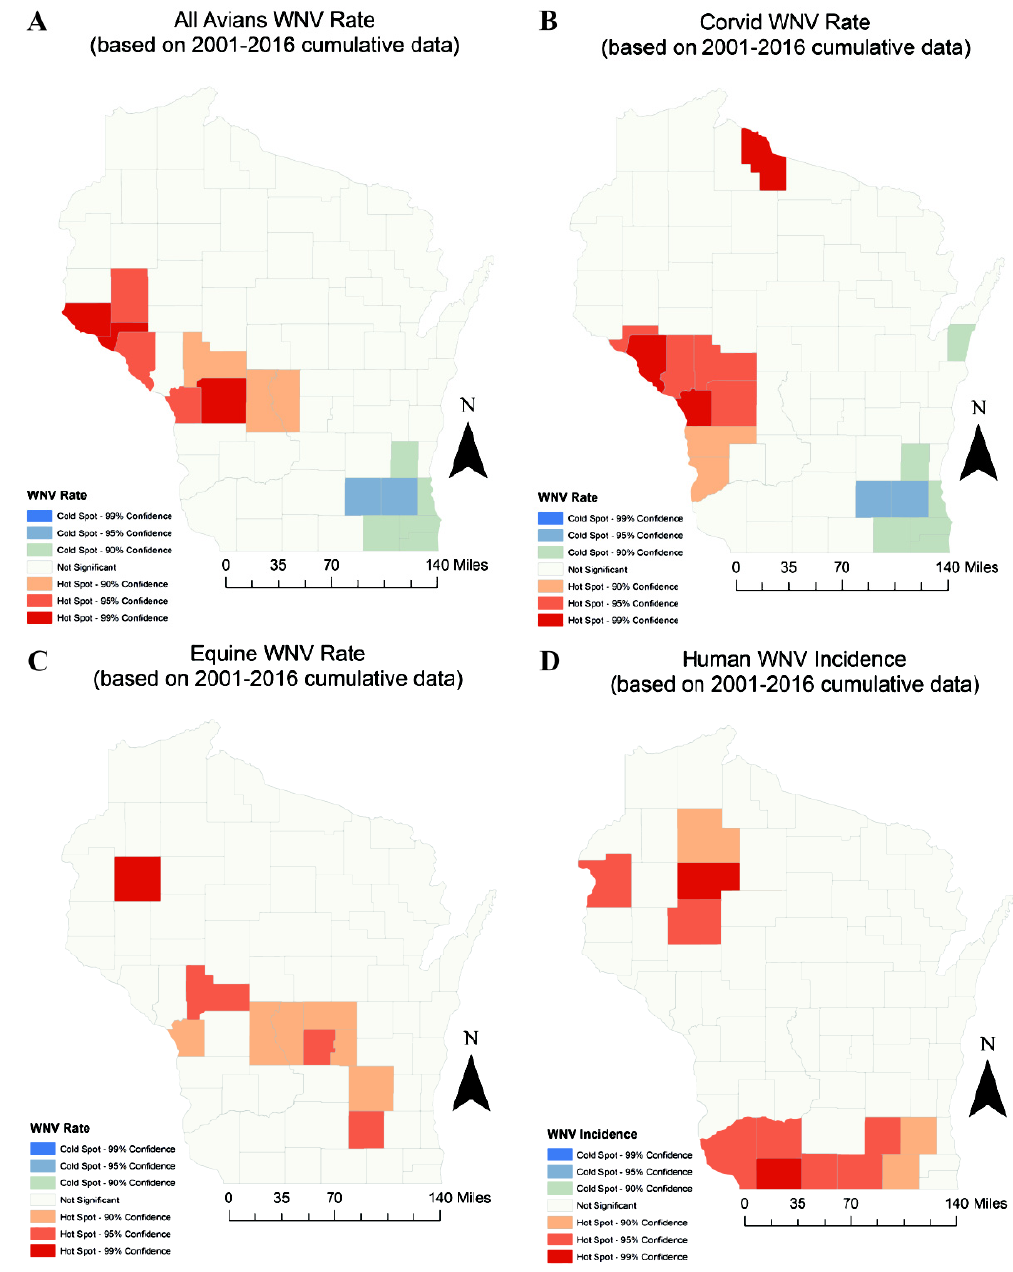
Figure 3. Hot spot analysis for WNV in Wisconsin (all years pooled), by all avian ( A ), corvid ( B ), equine ( C ), and human ( D ) cases. Red areas indicate statistical clustering while blue areas indicated statistical dispersal relationships. Yellow areas indicate non-significance and white areas had no case to assess.